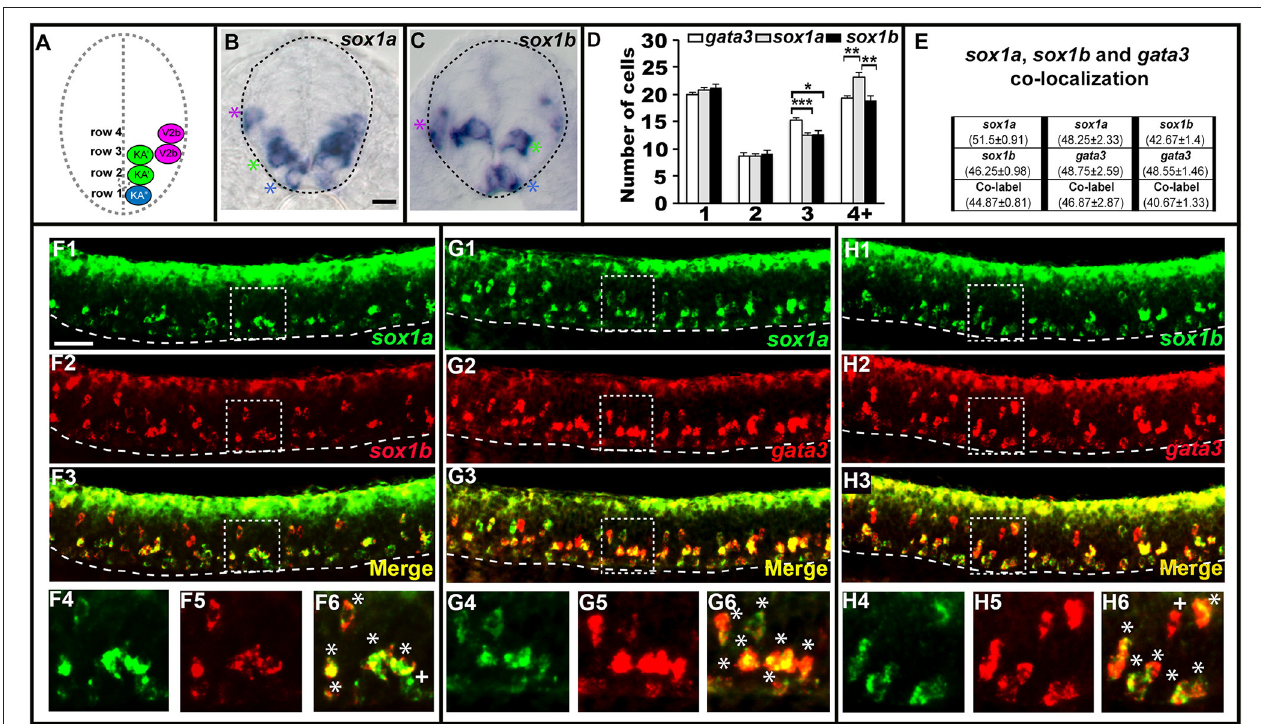
FIGURE 4 | sox1a and sox1b are co-expressed in KA ′′ , KA ′ , and V2b cells. Cross-sectional (A–C) and lateral (F–H) views of 24h WT zebrafish embryos. Dorsal, top; in lateral views, anterior is left. Dashed lines indicate spinal cord boundary (A–C) or ventral limit of the spinal cord (F–H) . (A) Schematic indicating positions of KA ′′ , KA ′ , and V2b neurons. (B) sox1a and (C) sox1b expression in KA ′′ (blue asterisks), KA ′ (green asterisks), and V2b (magenta asterisk) cells. (D) Mean number of cells expressing gata3 , sox1a, or sox1b in each D/V row of spinal cord region adjacent to somites 6–10. All counts are an average of at least 5 embryos. Error bars indicate SEM. Statistically significant ( P < 0.05) comparisons are indicated with square brackets and stars. *** P < 0.001, ** P < 0.01, * P < 0.05. There are no statistically significant differences between the numbers of cells expressing each of these genes in rows 1 and 2. While there are differences in rows 3 and 4, these are small and may reflect slight differences in timing or levels of expression and/or “noise” between different experiments as each gene was analyzed in different embryos. For P -values of all comparisons see Supplementary Table 3. (E) Quantification of single and double-labeled cells from double fluorescent in situ hybridization experiments (F–H) . Each column indicates the mean number of cells ± SEM expressing each gene and co-expressing the two genes. Double fluorescent in situ hybridization co-expression experiments showing expression of sox1a (green) and sox1b (red) (F) , sox1a (green), and gata3 (red) (G) , sox1b (green) and gata3 (red) (H) . Bottom row panels are single confocal plane magnified views of the dashed box regions in panels above. White asterisks in (F6,G6,H6) indicate cells co-expressing both genes whereas white crosses indicate single-labeled cells. Dorsal labeling in (F1–H3) is background accumulated from several confocal planes. As labeling is often weaker in double in situ hybridization experiments, cells that are apparently single-labeled may co-express the other gene at levels undetected in these experiments. Consistent with this, slightly fewer cells are labeled with each in situ hybridization probe in the double-labeling experiments than in the single in situ hybridization experiments. In addition, occasional single-labeled cells may result from one of the genes being expressed slightly earlier than the other. Scale bars (B) = 10 microns (B,C) ; (F1) = 50 microns (F1–H3)